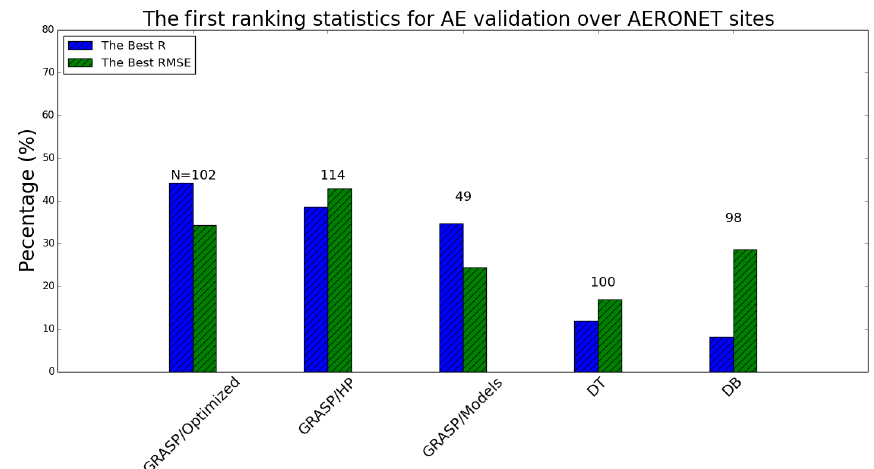
Figure 19. Percentage of the AERONET sites where each product shows the best statistical metric ( R and RMSE) between five PARA- SOL/GRASP and MODIS AE products. The number on top of each product is the number of sites where this product has sufficient matchup points for the comparison. Table 13. Statistics of PARASOL and MODIS AODC products against collocated AERONET AODC over land and